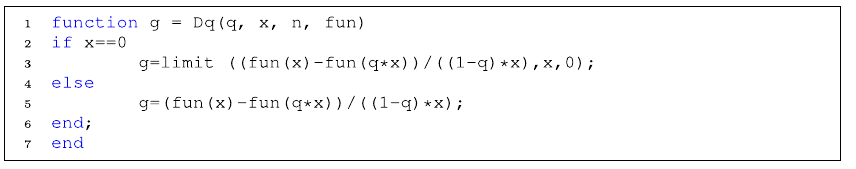
Algorithm 3 The proposed method for calculated ( D q f )( x